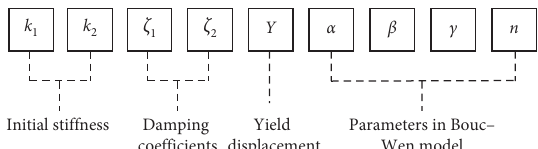
Figure 4: The parameters encoded in the IMPSCO.